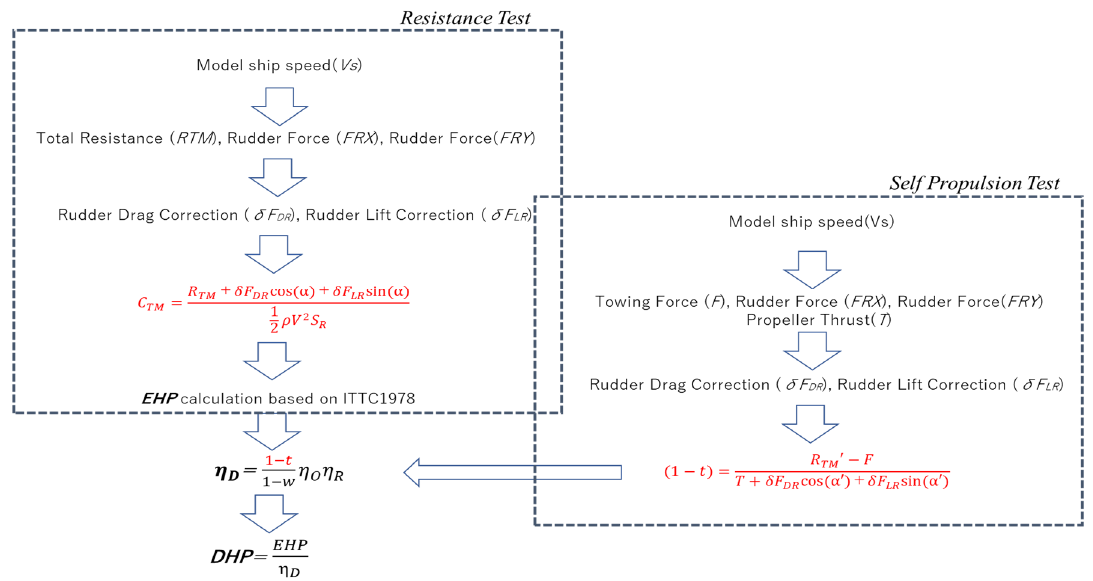
Figure 15. Algorithm for an enhanced powering performance procedure for a ship driven by a gate rudder system.